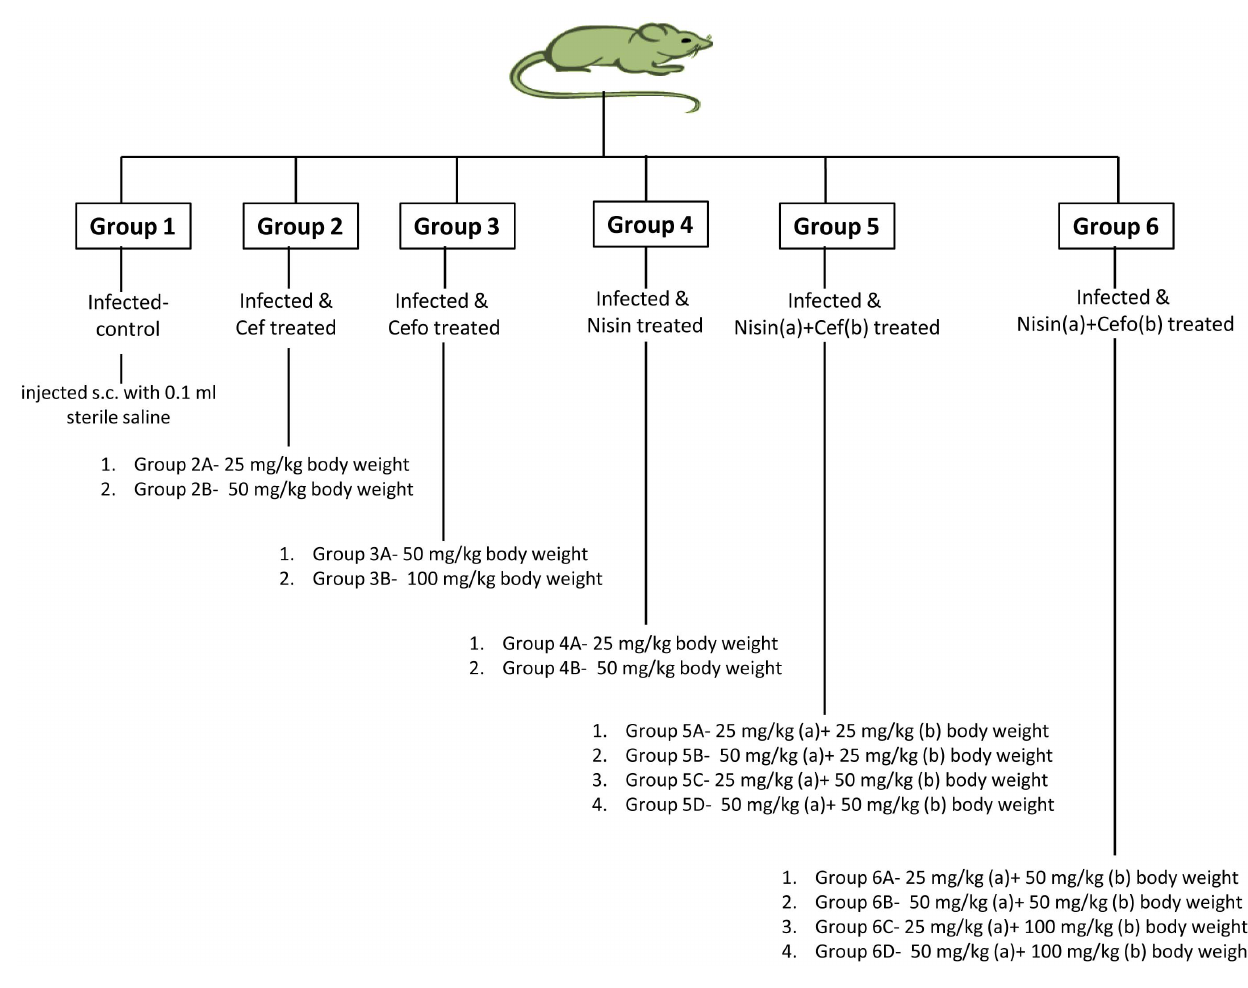
Figure 1. Diagrammatic representation of various treatment groups made for in-vivo studies. Uninfected-control group comprising 6 mice was also used in the study (not shown).